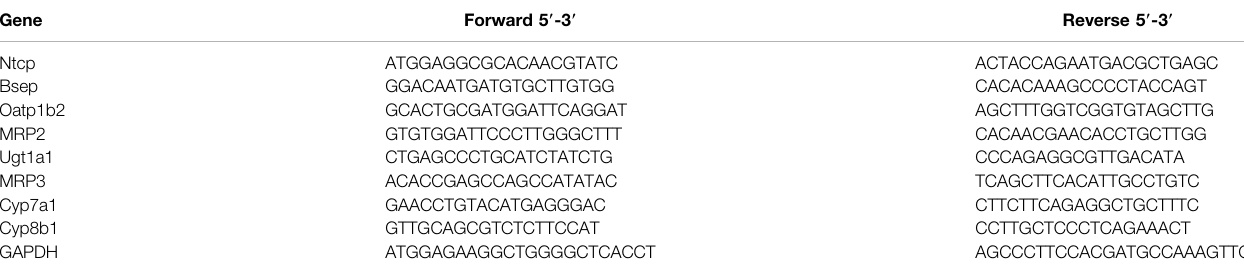
TABLE 2 | Sequences of primer for qPCR analysis in this